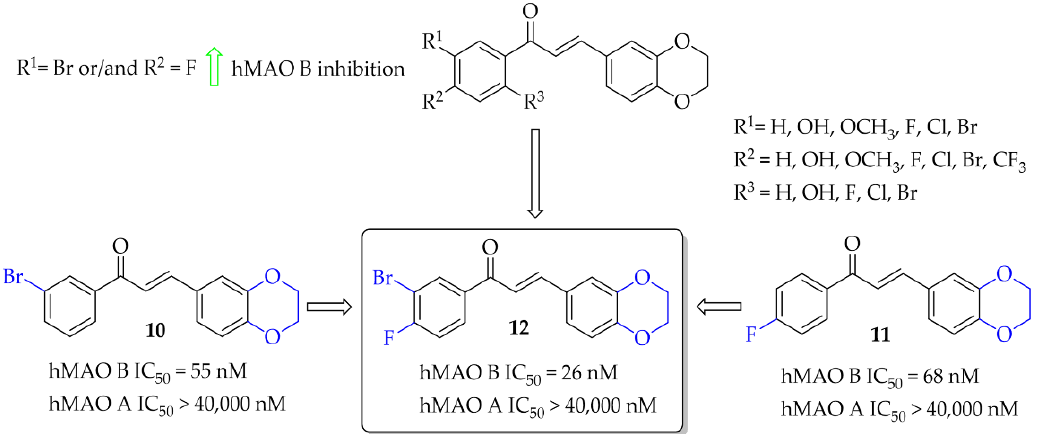
Figure 10. 1,4-Benzodioxan-substituted chalcones and the most potent compounds in the series